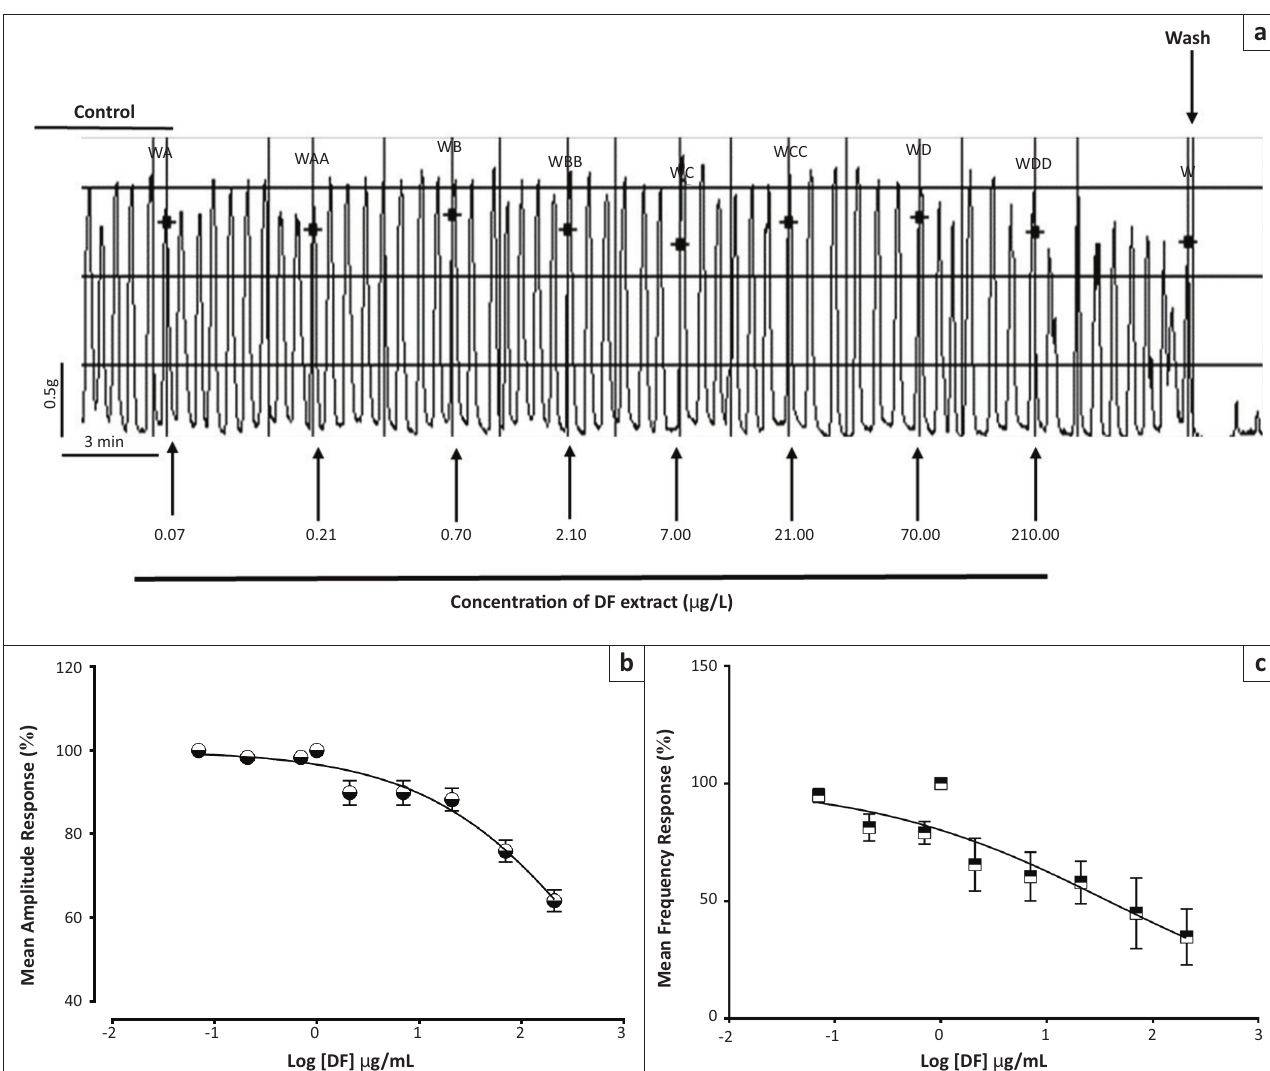
FIGURE 2: Effect of D. filix-mas (DF) on spontaneous uterine contraction. (a) Original recording showing the effect of DF on spontaneous contractility of the isolated mouse uterus. (b) Concentration–response curves showing the effect of DF on the amplitude of spontaneous uterine contractions. (c) Concentration–response curves showing the effect of DF on the frequency of spontaneous uterine contractions. A concentration-dependent inhibition for both the amplitude and frequency was observed. n = 5